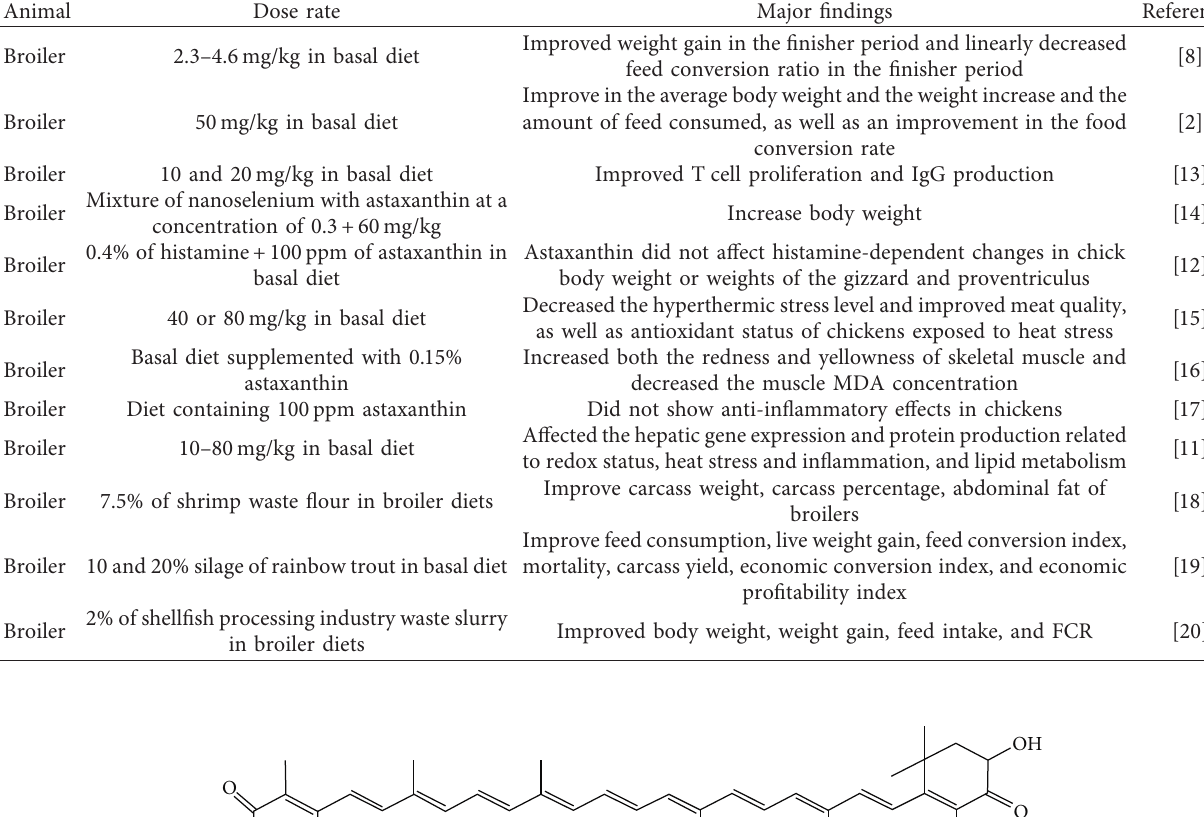
Table 1: Overview of recent application of astaxanthin in broiler